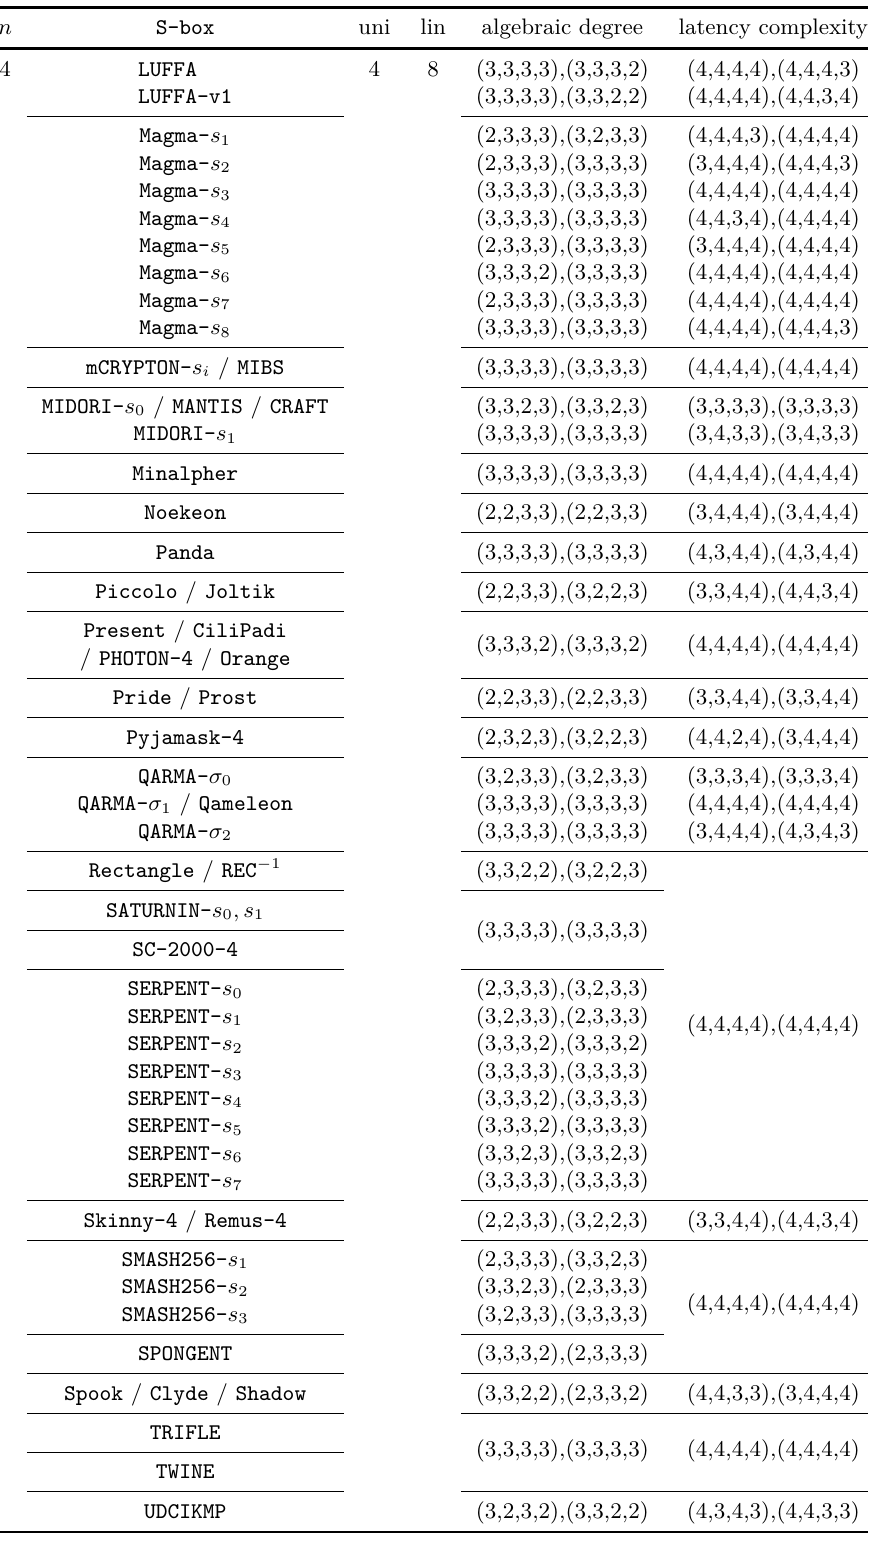
Table 7: Latency Complexity of Known S-boxes